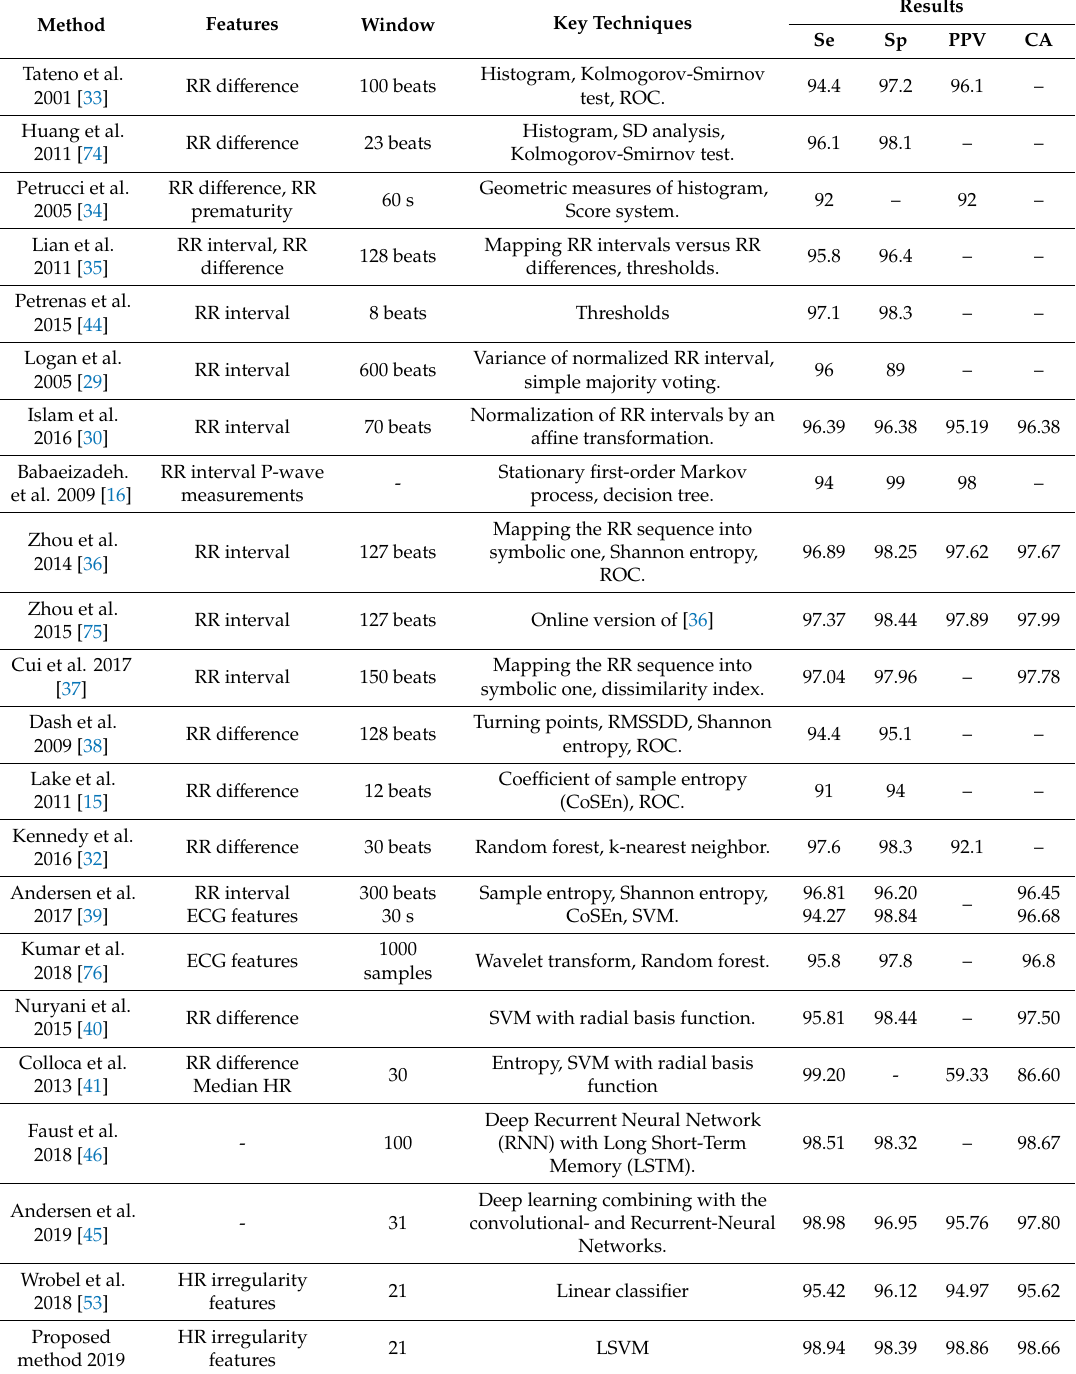
Table 6. An overview of published results of existing AF detection methods using the MIT-BIH Atrial Fibrillation